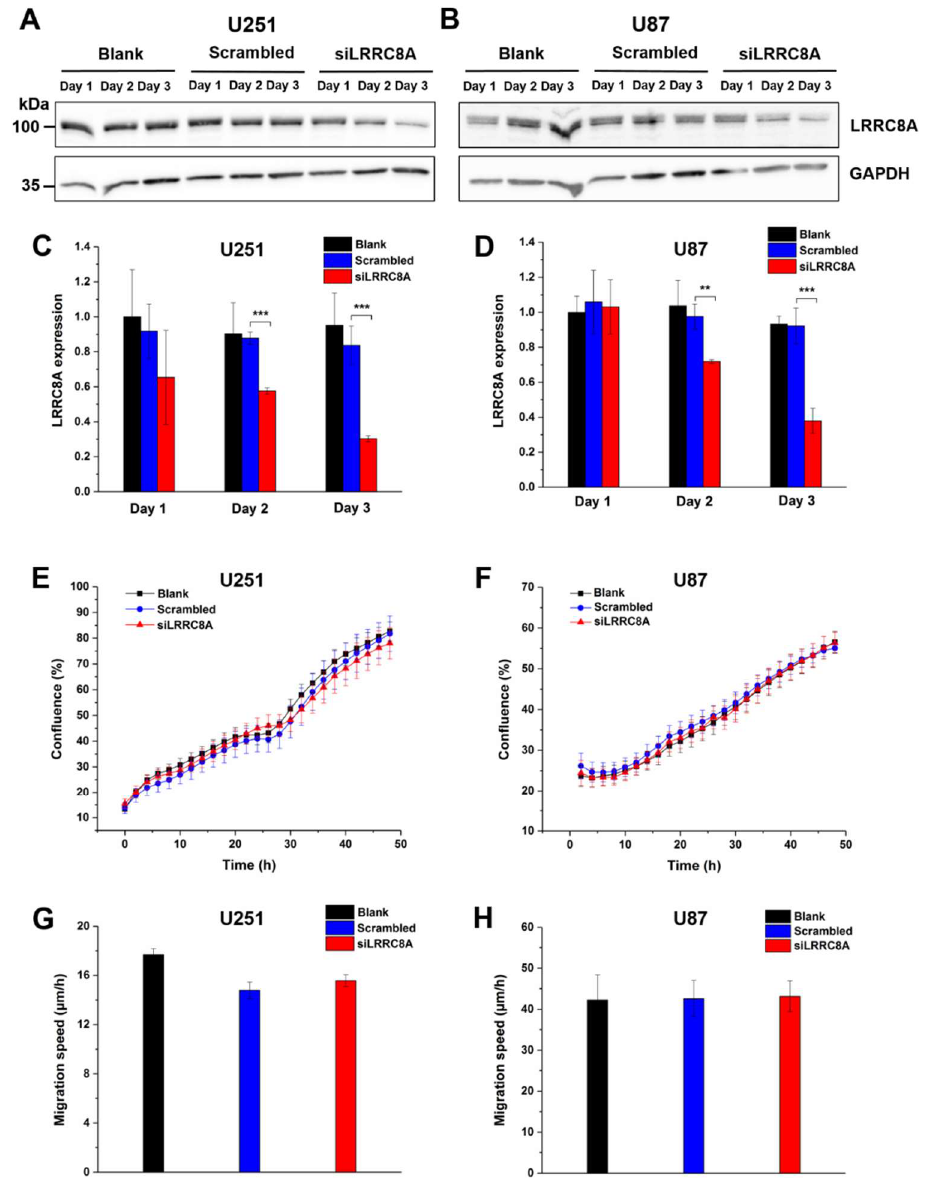
Figure 4. Downregulation of LRRC8A does not affect GBM cell growth and motility. Expression of LRRC8A protein significantly decreased after U251 ( C ) and U87 ( D ) cells transfected with siRNA against LRRC8A for 48 h and 72 h. ** p < 0.01, *** p < 0.001 vs. scrambled. Data represent mean ± SD from n = 3 independent experiments. GAPDH on the same blot was used as an internal control. Representative blots of three independent experiments for U251 ( A ) and U87 ( B ) were shown. Proliferation of U251 ( E ) and U87 ( F ) started 48 h after transfection with siRNA against LRRC8A. Data represent mean ± SD of n = 8 experiments. ( G ) U251 cell migration started after 48 h transfection with siRNA against LRRC8A. The data were calculated after cell migrated for 24 h. Data represent mean ± SD of n = 5 experiments. ( H ) U87 cell migration started after 48 h transfection with siRNA against LRRC8A. Note the high values due to absence of mitomycin in the wound healing assay in this case. The data were calculated after cell migrated for 14 h. Data represent mean ± SD of n = 7 experiments.